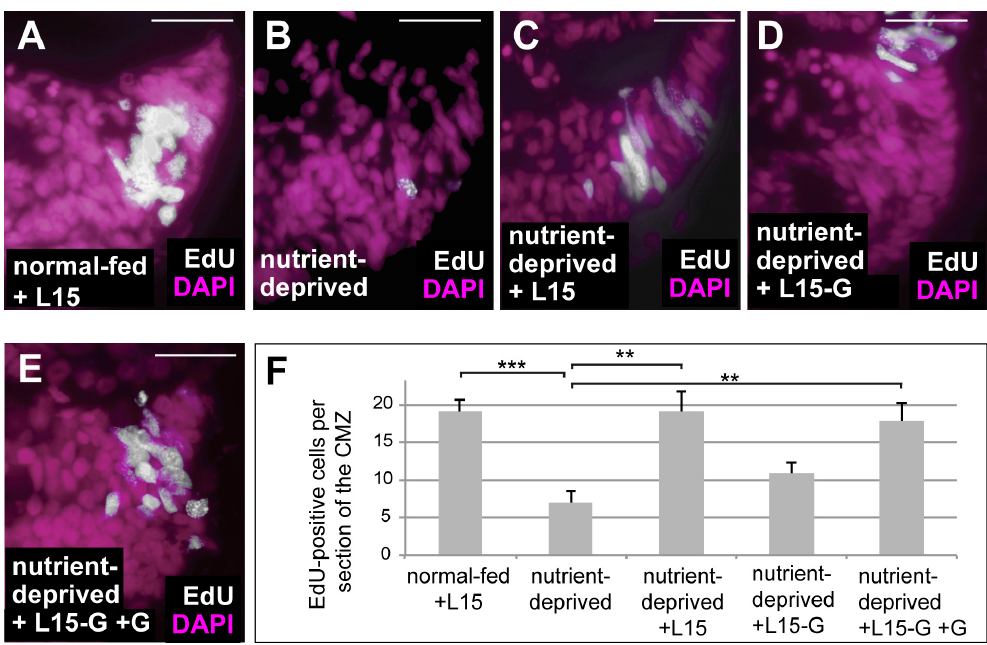
Figure 3. Glutamine is essential for retinal progenitor cell proliferation. ( A – E ) EdU incorporation in DAPI-stained ex vivo retinal explants from normal-fed embryos maintained in L15 medium for 24 h ( A ), from ND embryos maintained in 1× MBS for 24 h ( B ) or from ND embryos re-fed for 24 h with L15 ( C ), L15 lacking glutamine ( D ) or L15 lacking glutamine with added glutamine ( E ). Removal of glutamine from L15 medium prevented the rescue in proliferation observed following re-feeding. ( F ) Quantification of the experiment performed in ( A – F ). Error bars are standard deviations between three independent experiments. Two hooked ends of horizontal lines indicate the two conditions compared, ** p- values < 0.01, *** p- value < 0.001; scale bars = 20 µm; n = 3. Each experiment used six retinas per condition. These were from six different animals per condition ( i.e. , one retina from each animal).